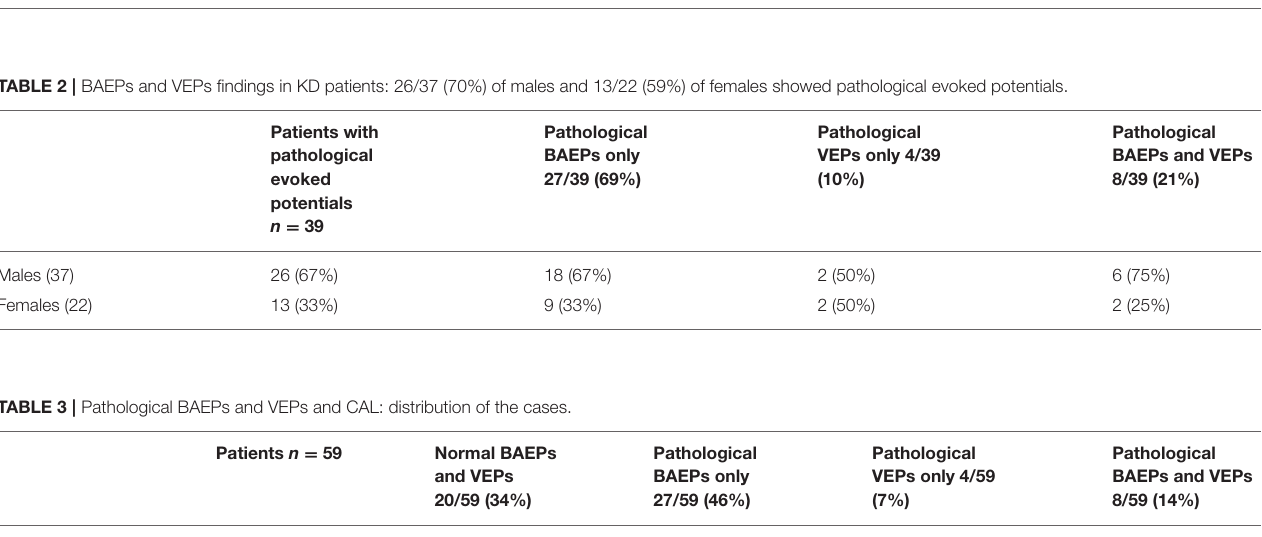
TABLE 4 | BAEPs and VEPs during the acute phase and 12 months after the onset of the disease. Patients with pathological evoked potentials